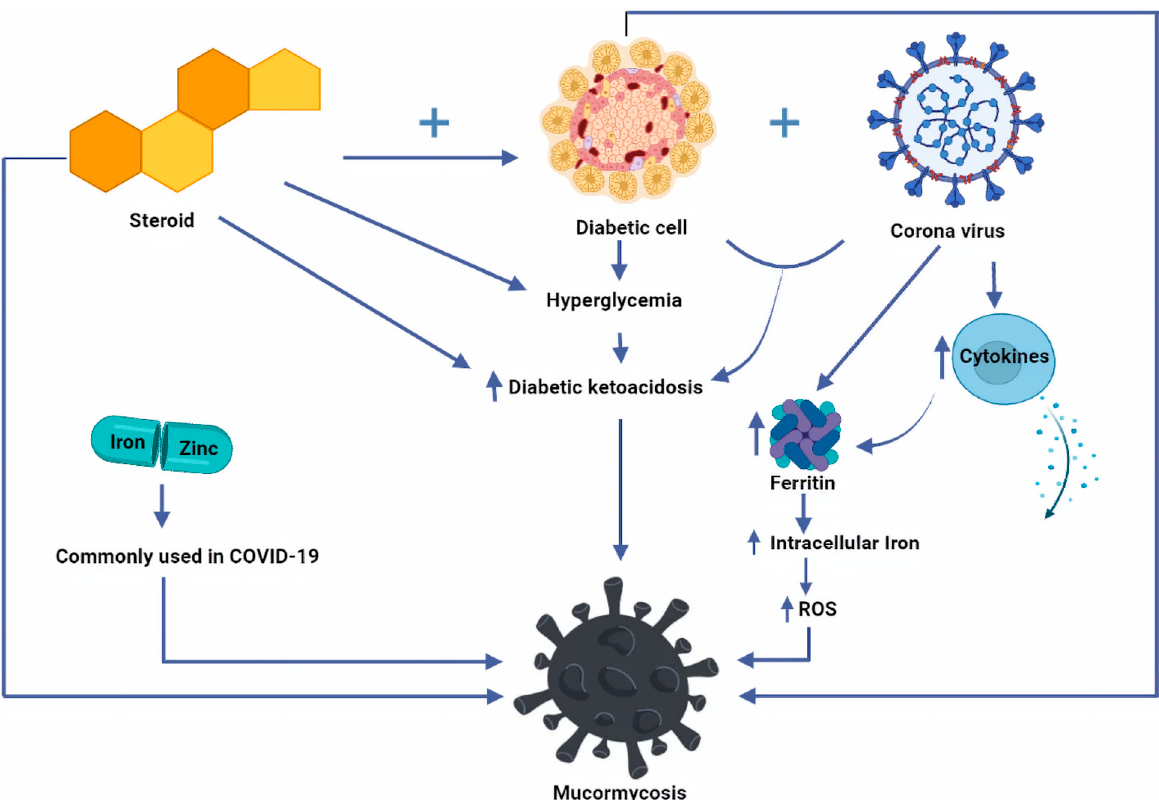
Figure 2. Pictorial representation of etiopathogenesis of mucormycosis in Covid-19 patients.